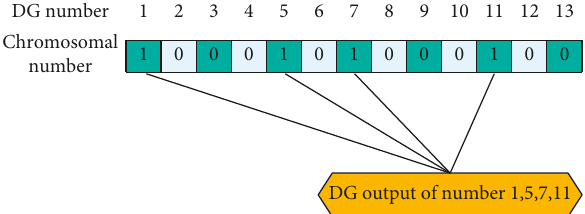
Figure 2: Chromosome coding of the upper-level model of the microgrid double-layer economic